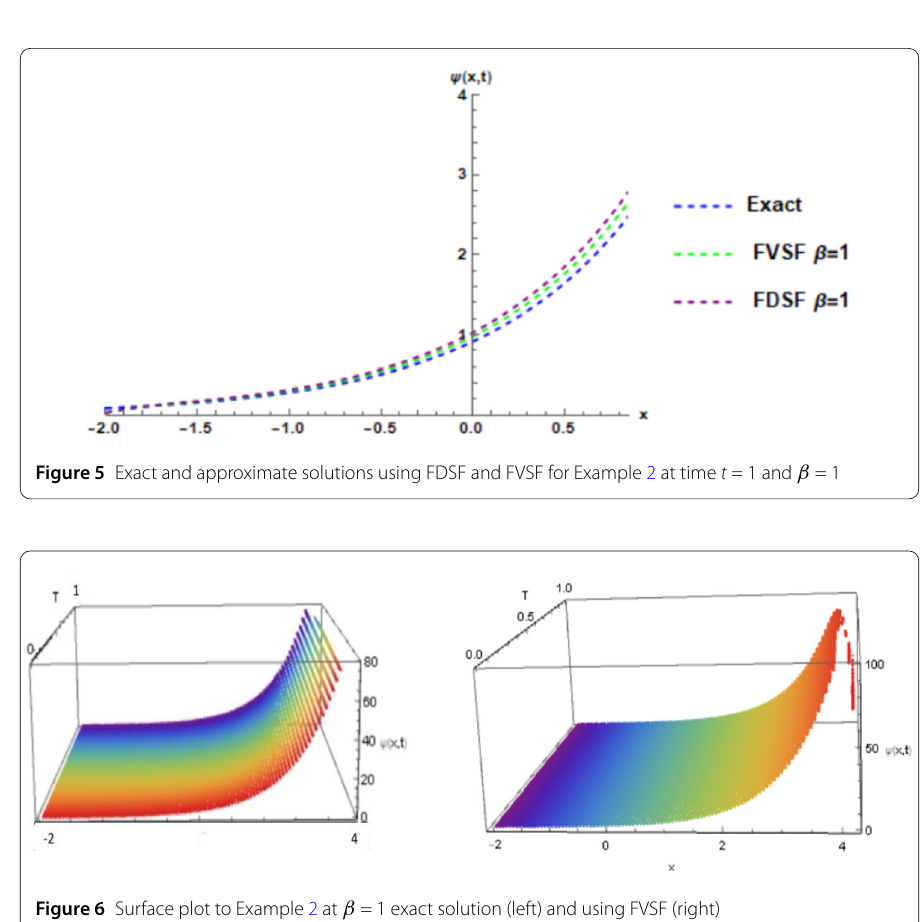
sense. The Grünwald–Letnikov fractional formula has been used for the discretization of space fractional derivative, and in both formulations the implicit scheme has been intro- duced. It has been shown that both schemes are stable with first-order accuracy in time and second-order accuracy in space. Numerical results have been found using Mathemat- ica software 11.0. Comparing illustrated examples justified the efficiency and accuracy of the proposed